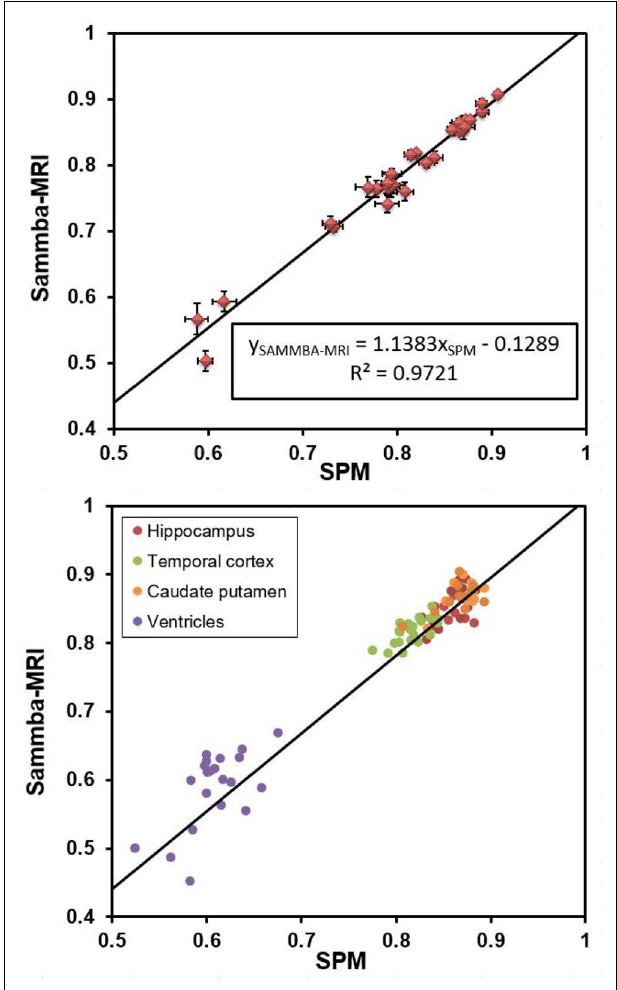
FIGURE 5 | Dice coefficients obtained after registering individual images to a rat brain templates with Sammba-MRI and SPM/Dartel. (Top) Comparisons showing 27 brains regions. Bars represents standard error of the mean. (Bottom) Individual measures for four different brain